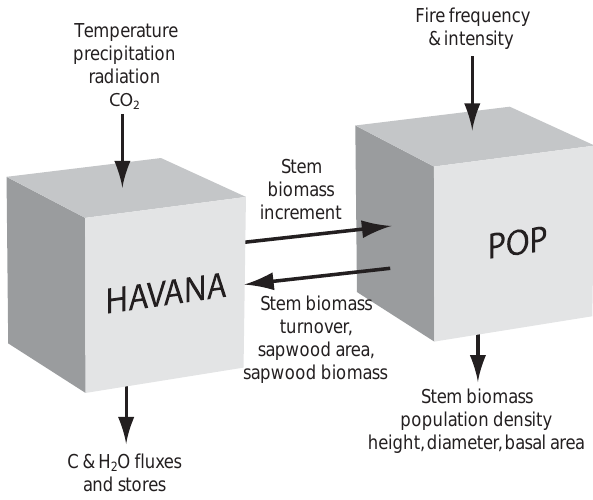
Figure A1. HAVANA–POP